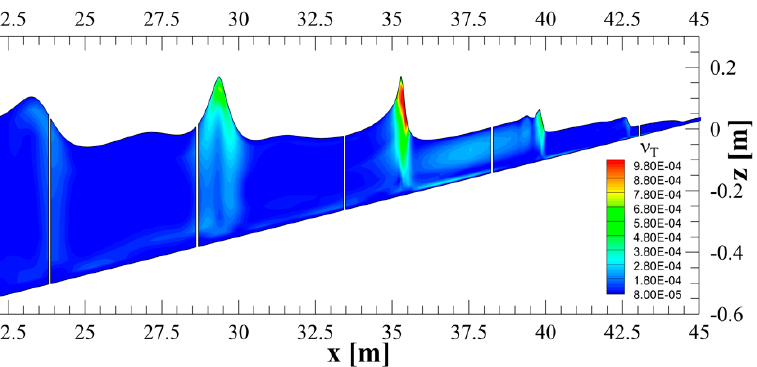
Figure 3. Test 2. Spilling/plunging breaking wave. Instantaneous free-surface elevation and contour of the eddy viscosity obtained using the proposed WTENO model.